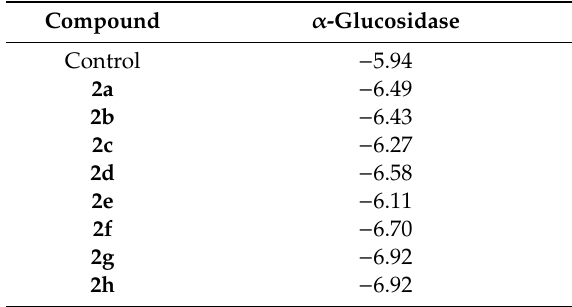
Table 3. Estimated binding free energy (kcal / mol) calculated from docking simulation for control docking and test compound 2a–2h with the built structure of α